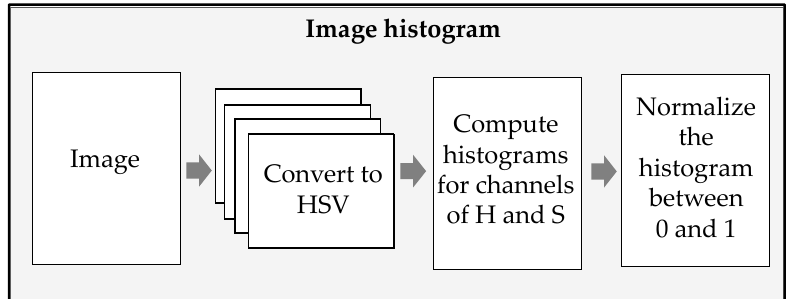
Figure 2. Image scaling